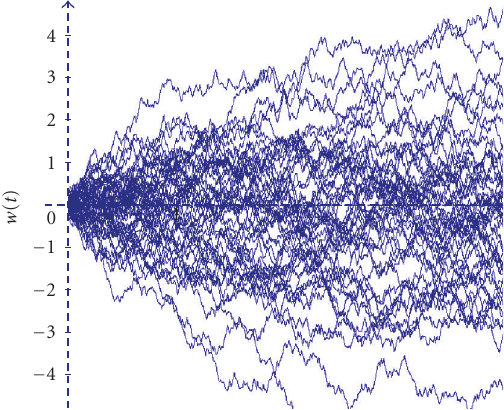
Figure 7.2 . Trajectories of Wiener